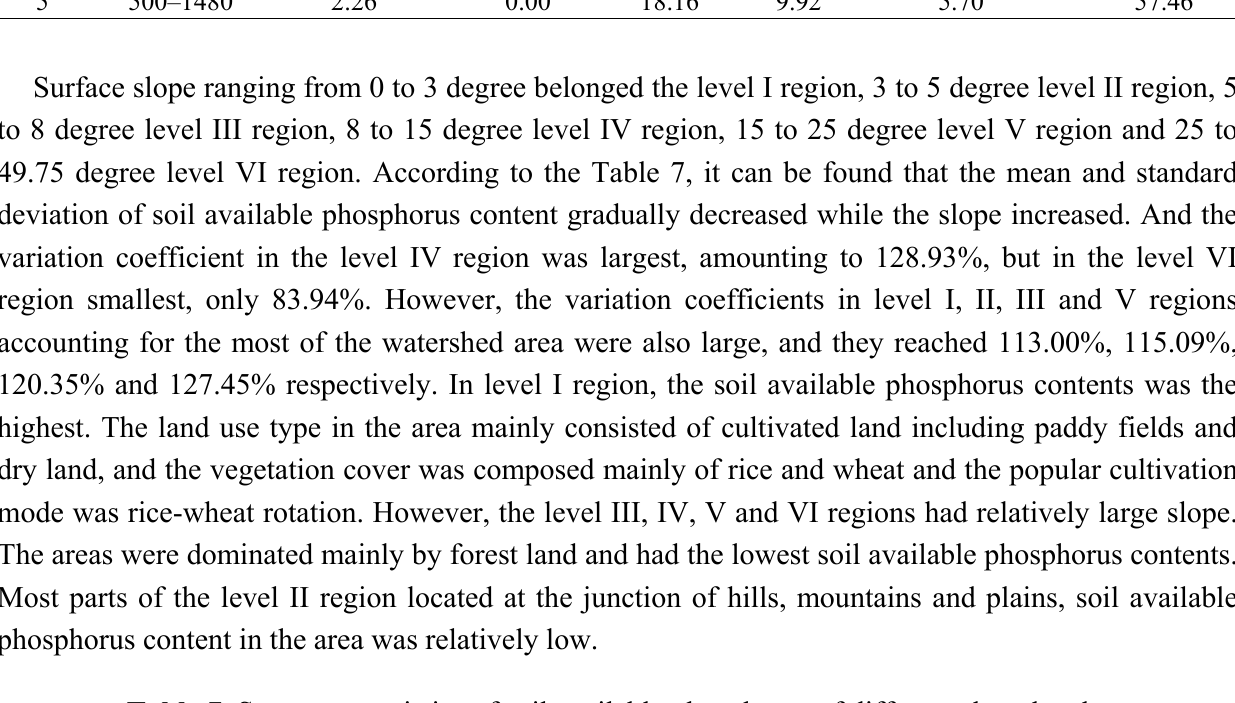
Table 7. Summary statistics of soil available phosphorus of different slope levels.